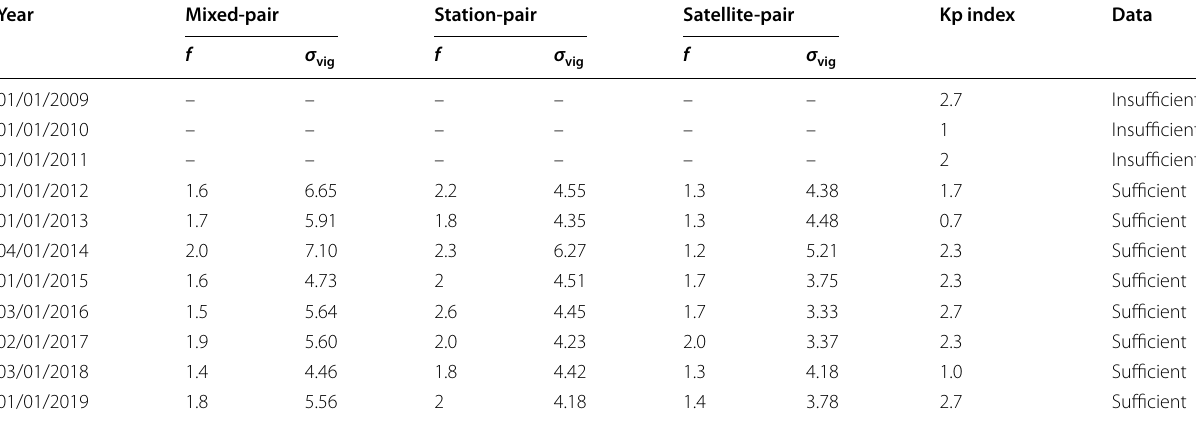
in the unit of vig